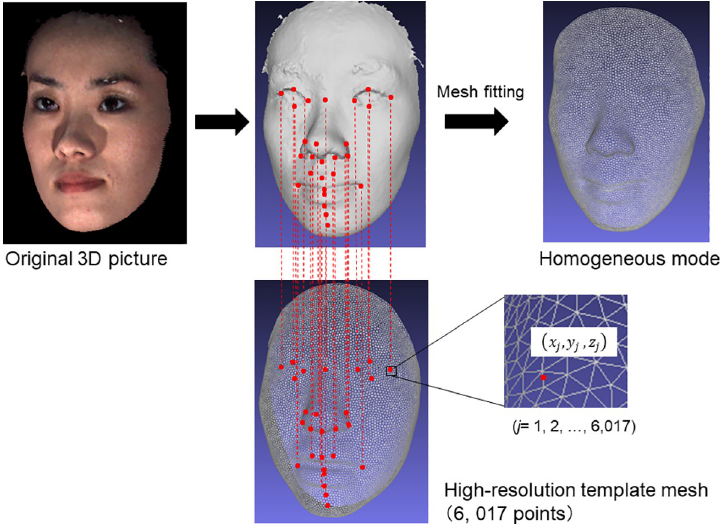
Fig 2. Three-dimensional image of the mesh fitting method. For each facial model, template meshes were fit using a software program, based on landmarks. This method automatically generated a point cloud, creating a set of 6,194 data points in a 3D coordinate system for each facial